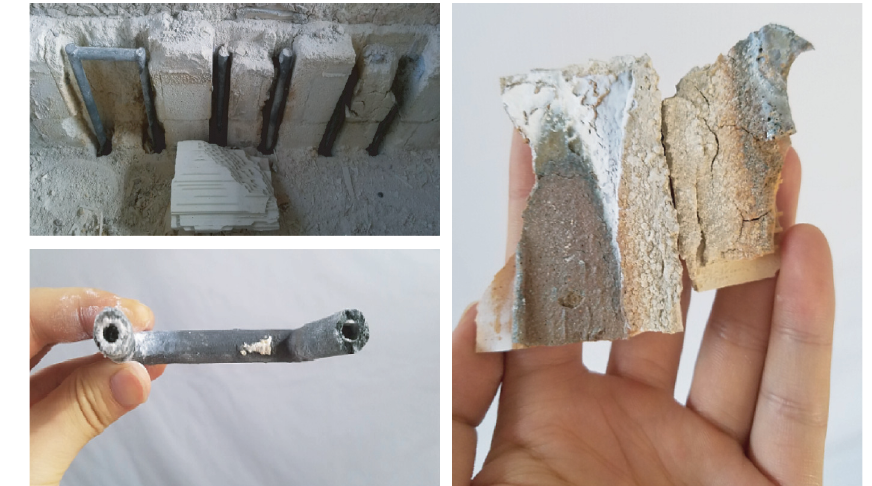
Figure 6: Fusing diagram of the heating rod.